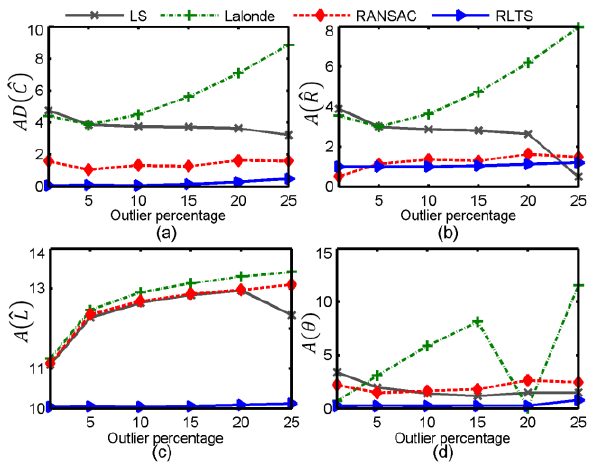
Figure 4. Influence of different percentages (1%,5%,10%,15%, 20% and 25%) of clustered outliers on cylinder fitting methods; line diagrams for outlier percentages versus performance